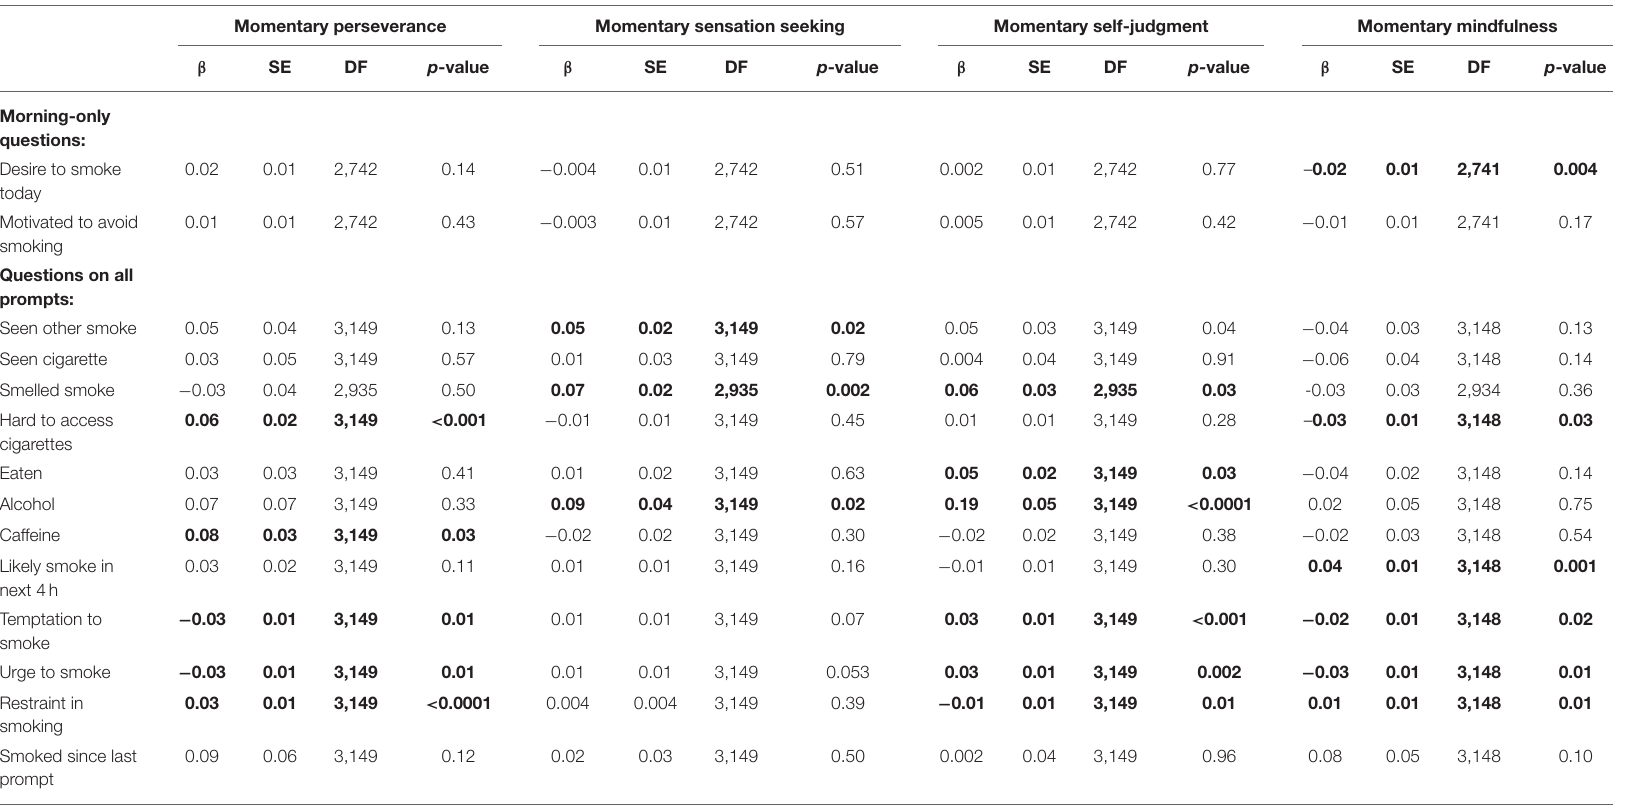
Parameter estimates from mixed-effects models. Bold values indicate p-values ≤